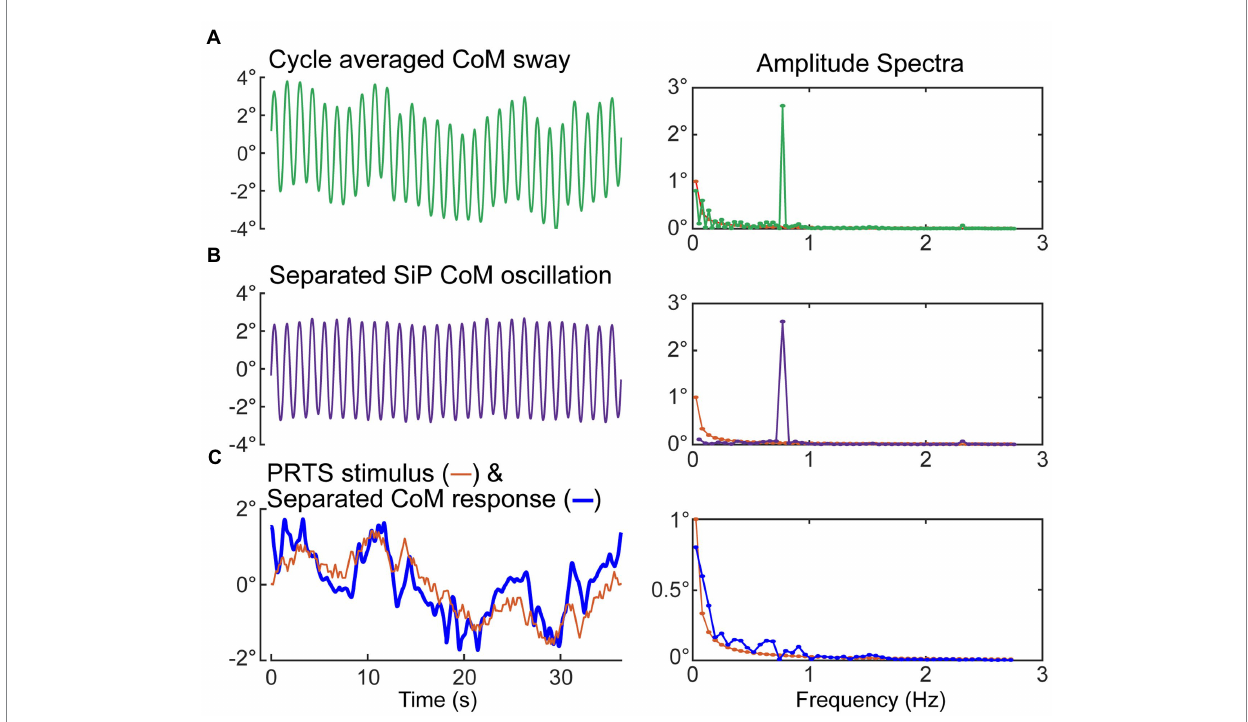
FIGURE 9 Separation of medial–lateral (ML) oscillation of the CoM during SiP from the CoM sway evoked by the ML pseudorandom PRTS surface-tilt stimulus. Metronome-paced trials with an even number of steps per stimulus cycle can be separated into the stimulus-evoked sway component and the oscillatory sway component. Left side plots show the cycle-average sway (A) , the separated oscillatory component at the stepping frequency (B) , and the separated stimulus-evoked CoM sway and the PRTS time course (C) . Corresponding amplitude spectra are shown in the right-side plots. The amplitude spectrum of the stimulus is shown in all right-side plots with only those harmonic components of the stimulus that have non-zero stimulus energy